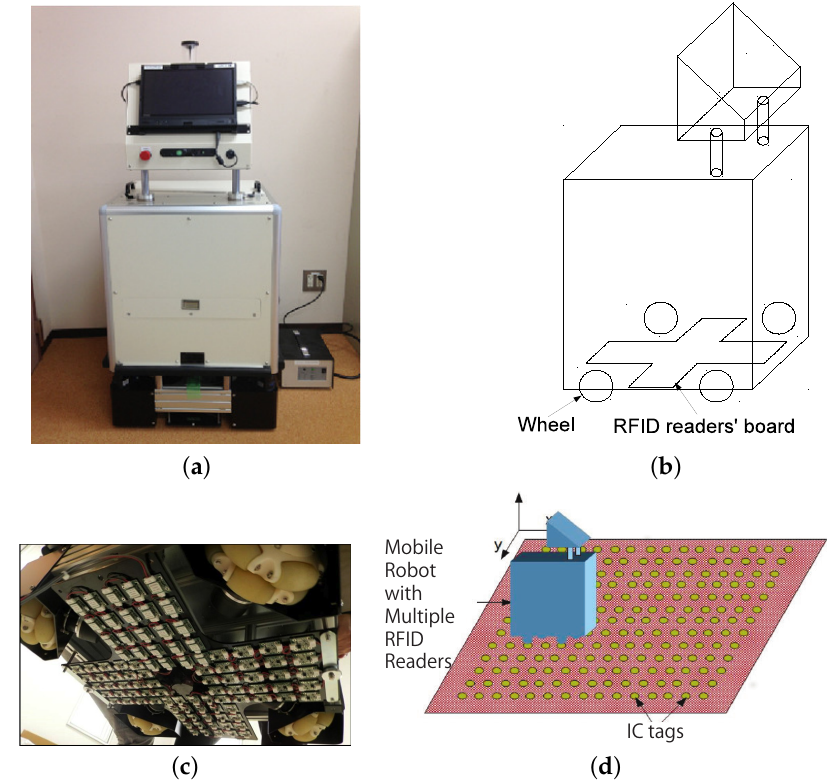
Figure 1. Self-localization of an indoor mobile robot using multiple RFID readers and RFID tags. ( a ) Omni directional vehicle; ( b ) structure; ( c ) multiple readers; ( d ) self-localization